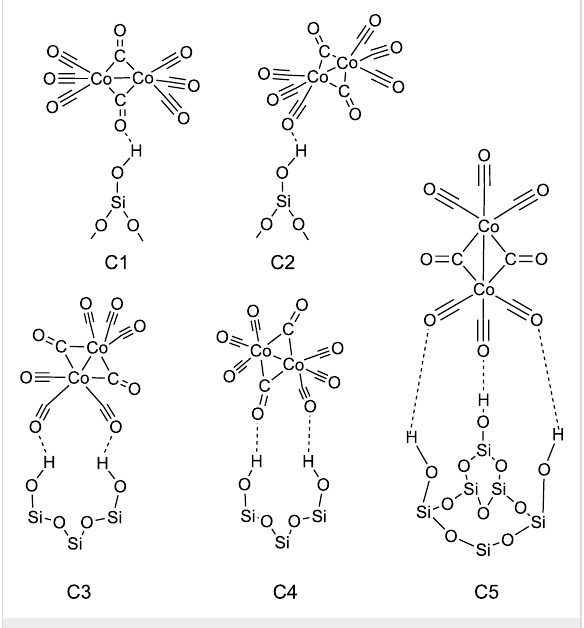
Figure 6: Schematic representation of the starting configurations with possible Co 2 (CO) 8 orientations, considered in this study, on FOH-SiO 2 surfaces. In POH-SiO 2 surfaces some of the OH groups are partially removed in order to simulate the pretreated surfaces.